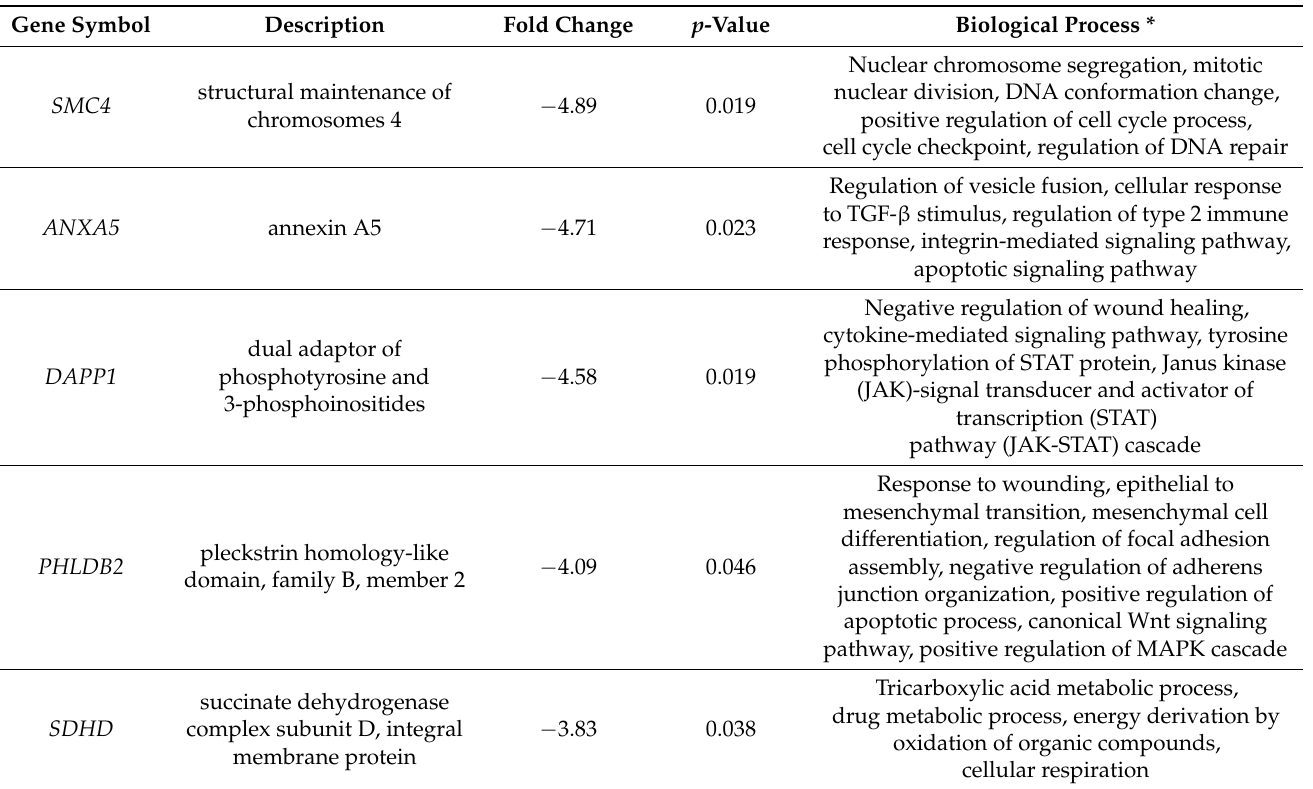
Table 3. Top significantly downregulated DEGs and their biological